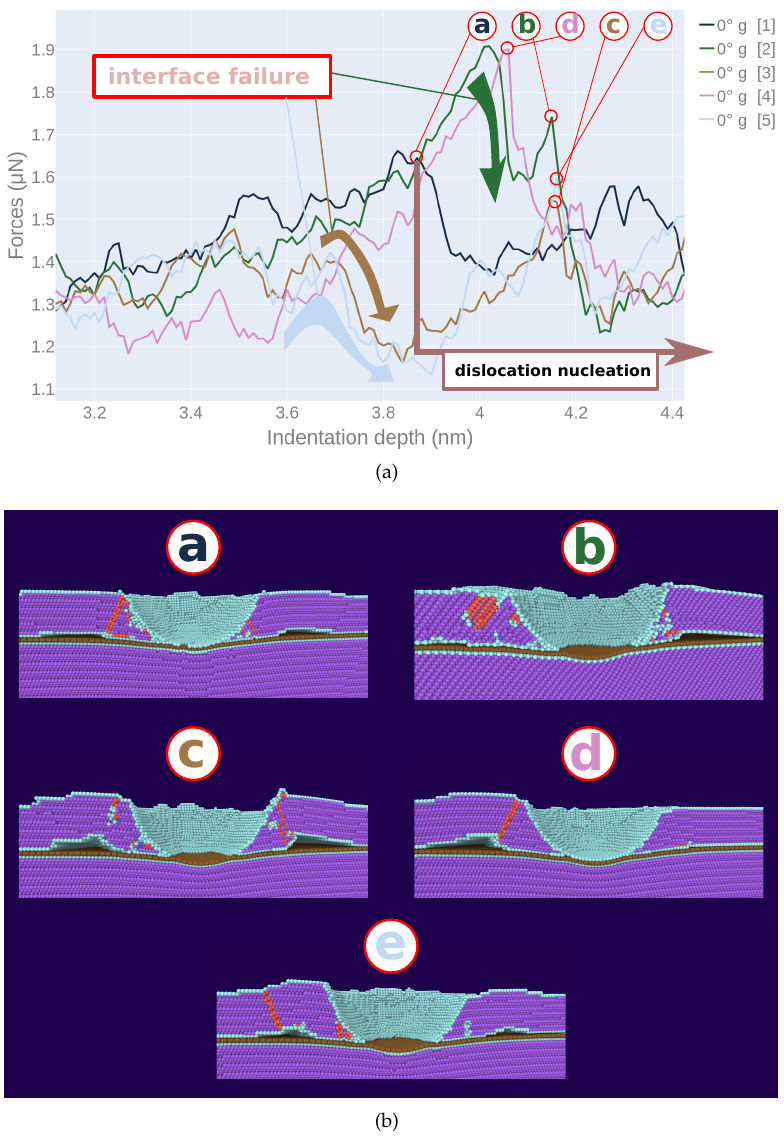
Figure 8. Indentation into single-crystalline Ni containing graphene (0 ◦ g ) at a depth of 3 nm. ( a ) force–depth curves for each individual indentation event. Circled points, a–e , indicate the indentation depth where dislocations start nucleating in the lower Ni block. ( b ) snapshots showing the microstructure induced at the indentation points, a–e , in panel ( a ). Atoms are colored as in Figure